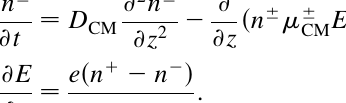
FIG. 7. Measurements ( (cid:5) ) and simulations ( . ) of the normal- ized mobility of 3 : 38 - (cid:1) m radius particles optically trapped in the midplane between the electrodes, as a function of the surfactant concentration (cid:2) m and of the applied dc voltage V dc . For increas- ing values of V dc , the micellar ions are increasingly separated, which reduces the electrophoretic retardation and increases the mobility. The saturation value is reached for values of V dc around 2 V. The simulations are based on the standard theory of electro- phoresis and on calculations of the local ionic strength, using the best-fitted relation (cid:1) n ¼ 2000 (cid:2) (cid:2) m (cid:1) m (cid:1) 3 for the equilibrium concentration of micellar ions. Similar to the experiments, the simulations are carried out with a 4-s delay between the dc voltage steps.